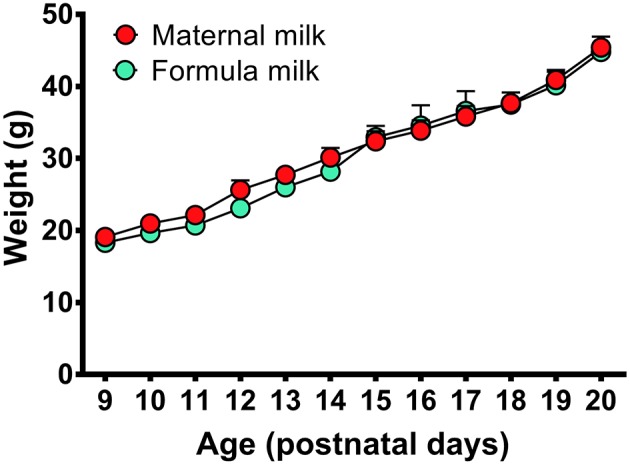
Weight gains in the P9-P20 pups fed respectively, by formula milk and maternal milk. The weight of pups fed with formula milk were not significantly different from that fed with their dam, though the weight gains in the pups fed with formula milk had a slight reduction at P10-P14. Values are means ± SEM (n = 5–6 in each age). Data are analyzed by Student's t-test.